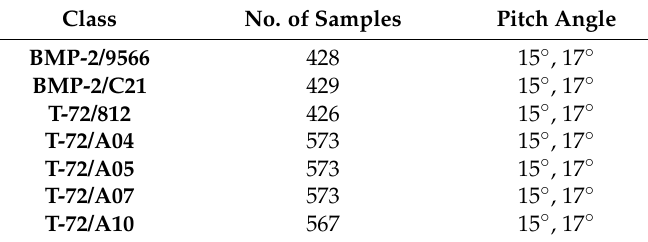
Table 7. Test set under EOC2 (version